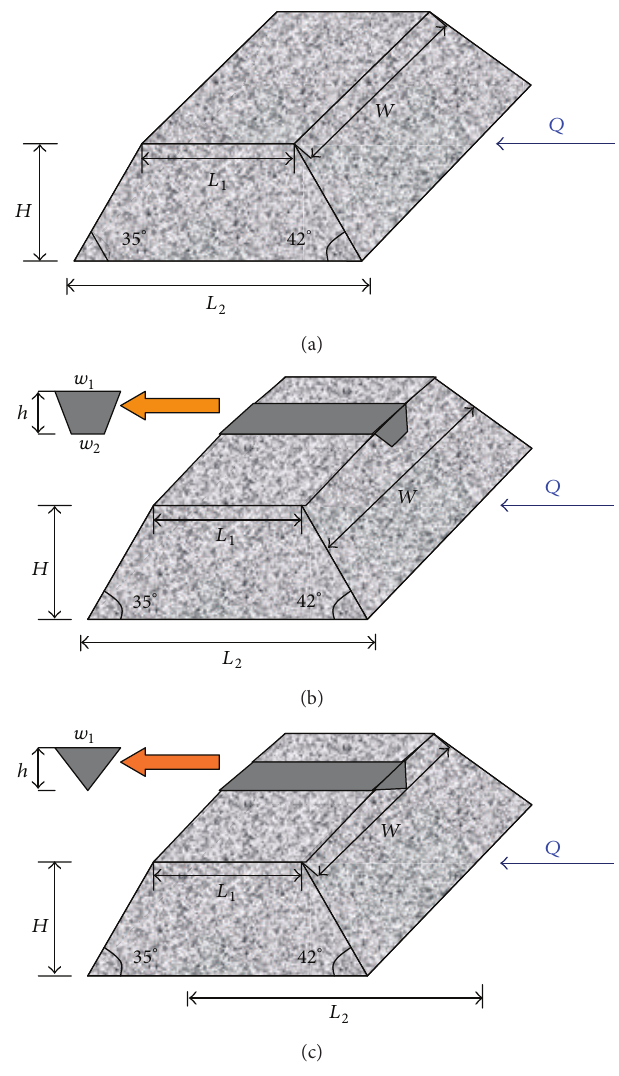
Figure 5: Schematic diagram of the different types of landslide dams used in this experiment: (a) basic landslide dam, (b) landslide dam with a trapezoidal discharge channel, and (c) landslide dam with a triangular discharge channel.